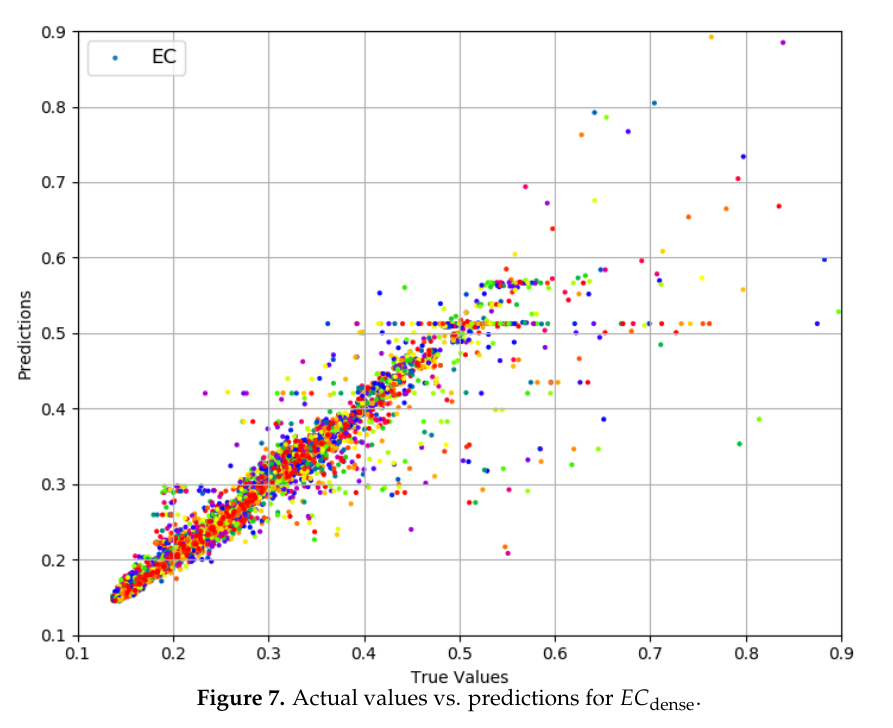
Figure 7. Actual values vs. predictions for EC dense .